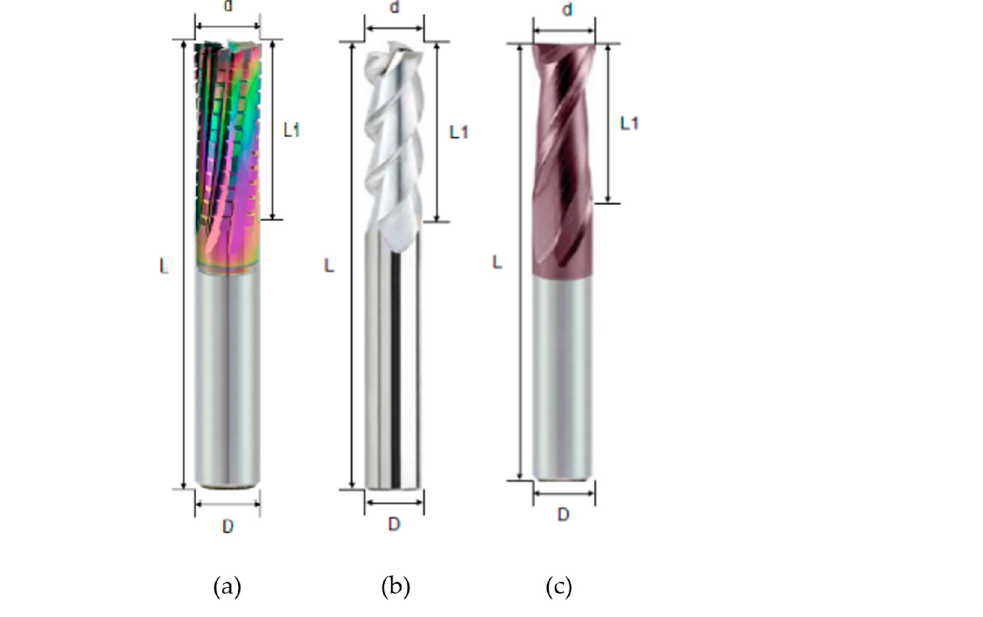
Figure 2. Tools used for the study. ( a ) ECSSF milling cutter; ( b ) A100 milling cutter; ( c ) G550 milling cutter. Table 3. Material properties of Table 2. General properties of tools.